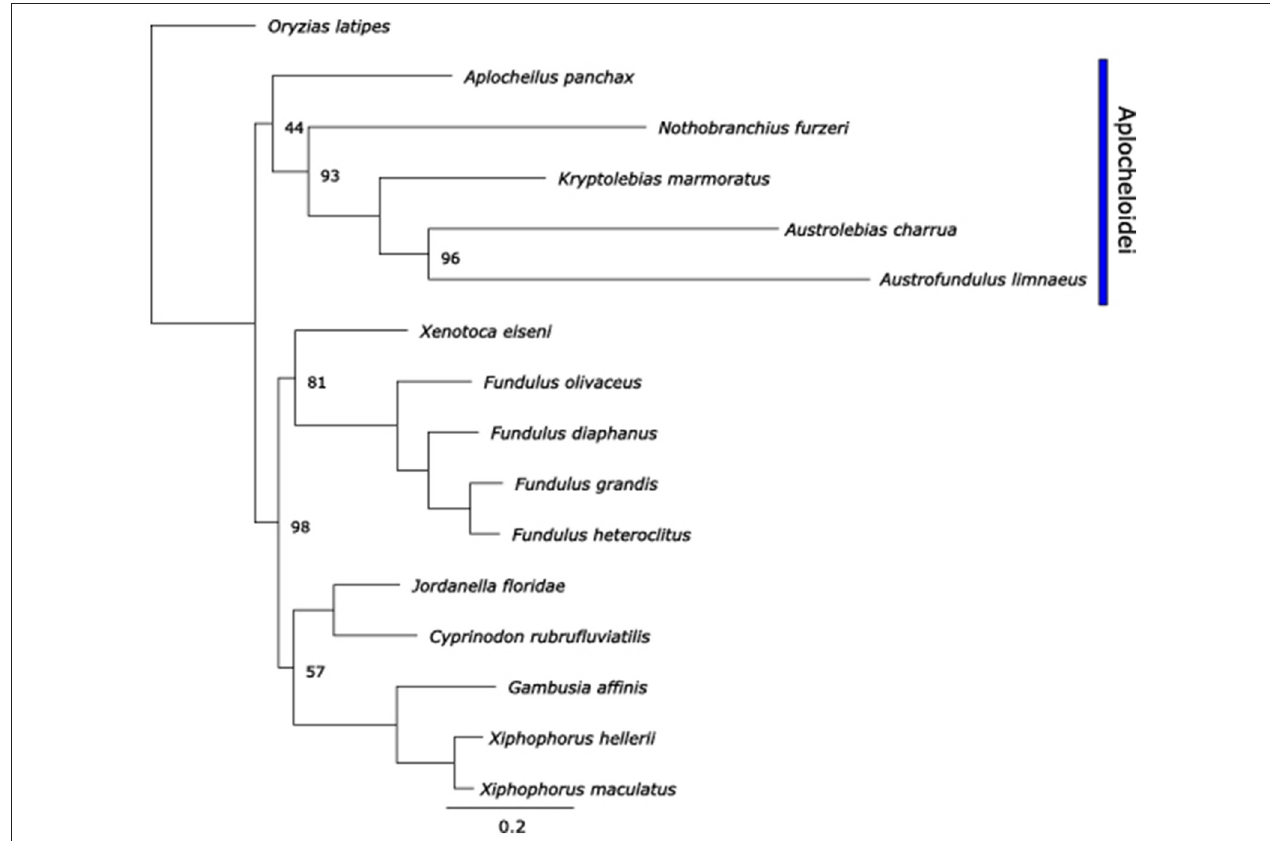
FIGURE 11 | Maximum-likelihood phylogenetic tree of species used in this paper using RAxML. Node bootstrap values are 100% unless indicated otherwise. Scale bar is nucleotide substitutions per